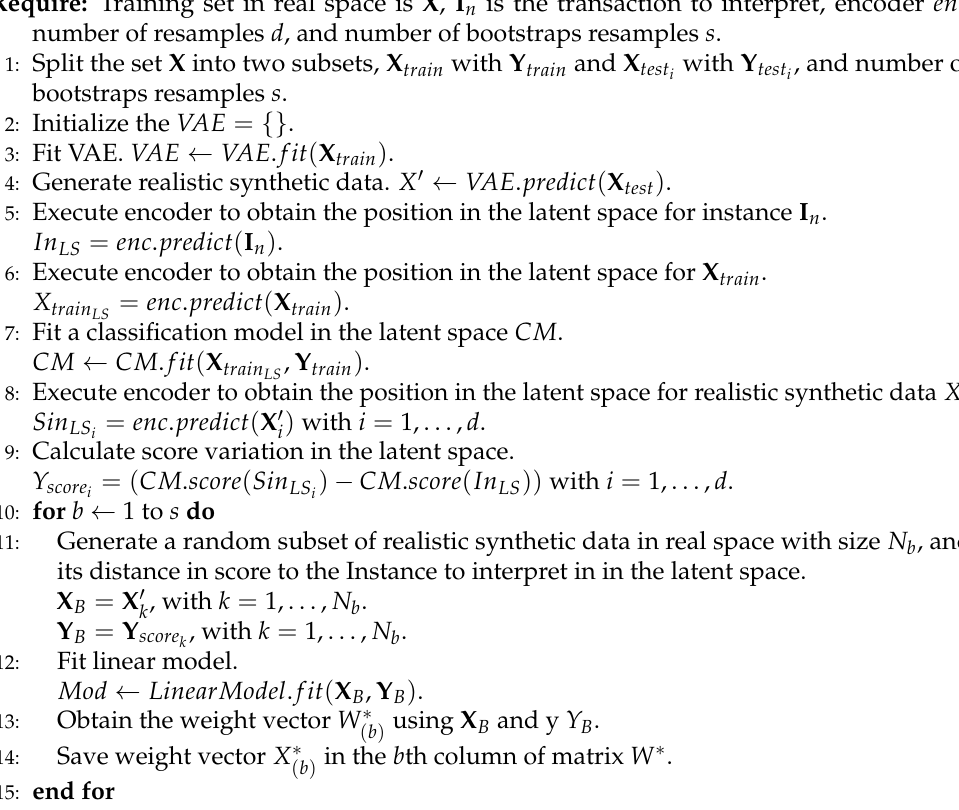
Algorithm 2 Interpretability. STE